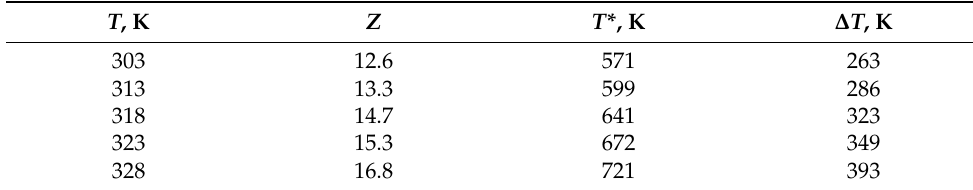
Table 2. Calculated values of T